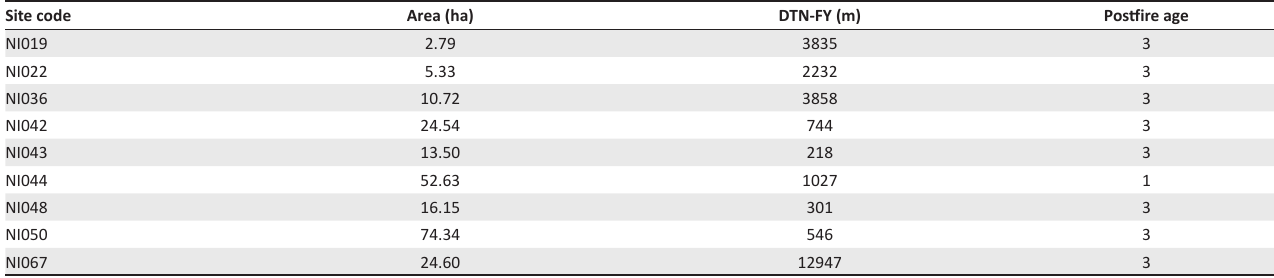
TABLE 1-A1: Physical characteristics of the natural islands included in the study. Site